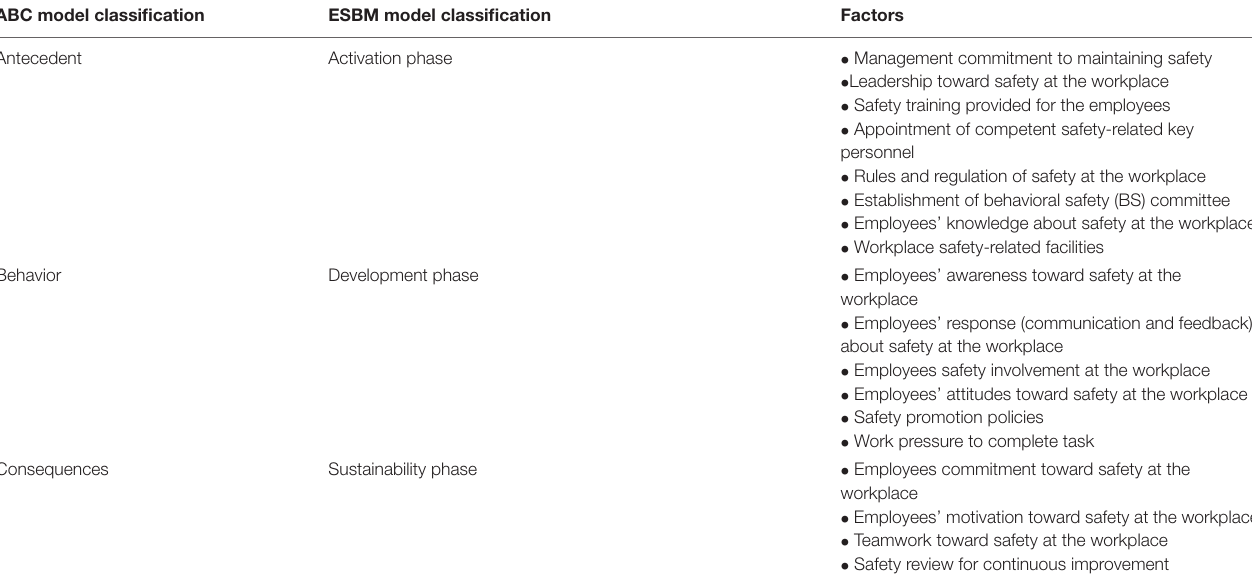
TABLE 6 | Similarity between ABC model and safety behavior